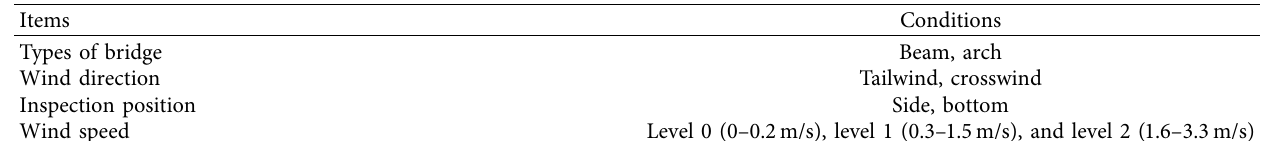
Figure 6: Experimental scheme and scene layout. Table 2: Experimental conditions.